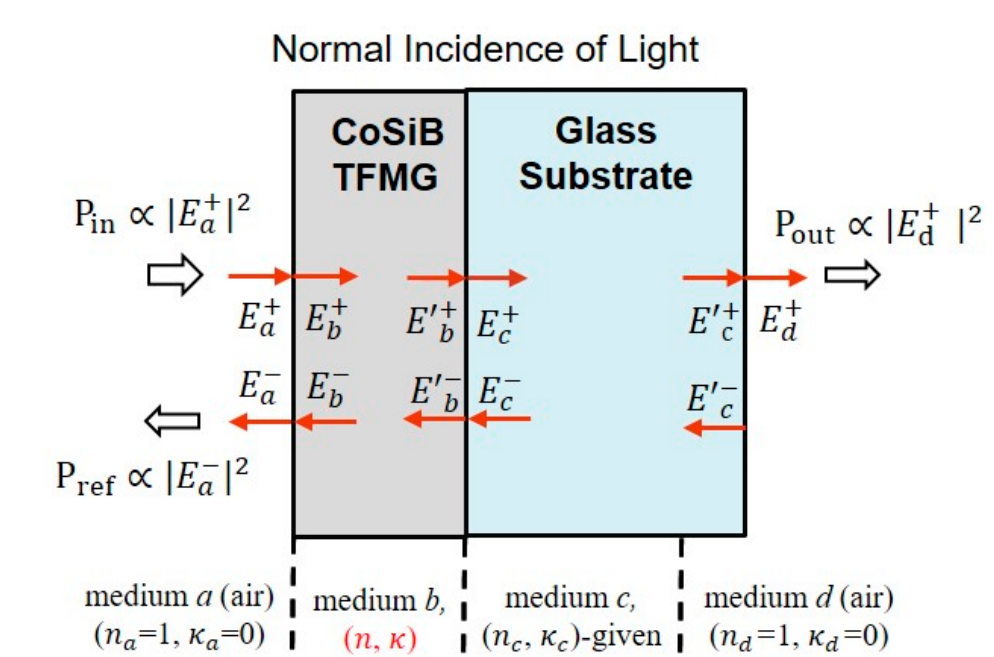
Figure 7. Schematic of light propagation through the TFMG (deposited on a glass substrate) at normal incidence. n and κ represent the refractive index and extinction coefficient, respectively.